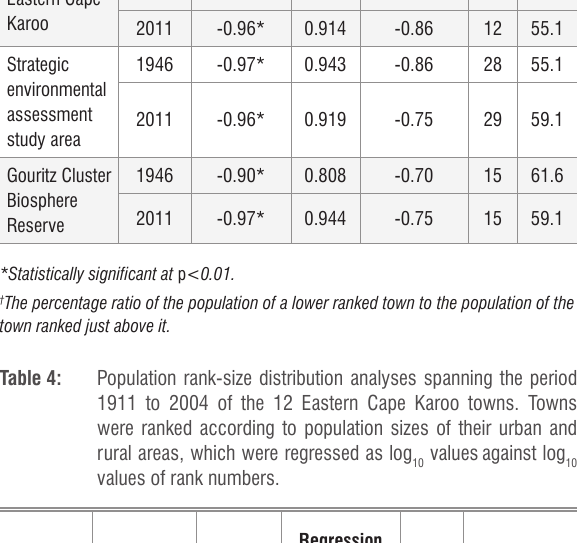
The rank-size relationships of enterprise numbers in 1946/1947 and 2013/2014 of the towns of the three regions and the ranks of their enterprise numbers are also described by power laws (Table 5). Figure 2 shows the relationship for the GCBR towns in 2013/2014. Except for the GCBR towns in 1946/1947, more than 90% of the variation was explained for both time periods (see R 2 in Table 5). This result is not unexpected given the often-observed linear relationship between population sizes and enterprise numbers of South African towns. 7-19 If the rank-size population distribution of towns in a region is described by a power law, the enterprise number rank-size distribution of the region should exhibit the same pattern. Figure 1: Example of a power law describing the rank-size relationship of population numbers (in 2011) of towns in the Gouritz Cluster Biosphere Reserve (GCBR), South Africa. The GCBR is used as an example. Table 3: Population rank-size distributions of three South African regions for 1946 and 2011. Towns were ranked according to population sizes, and then regressed as log values against 10 log values of rank numbers. 10 Time Region Correlation period